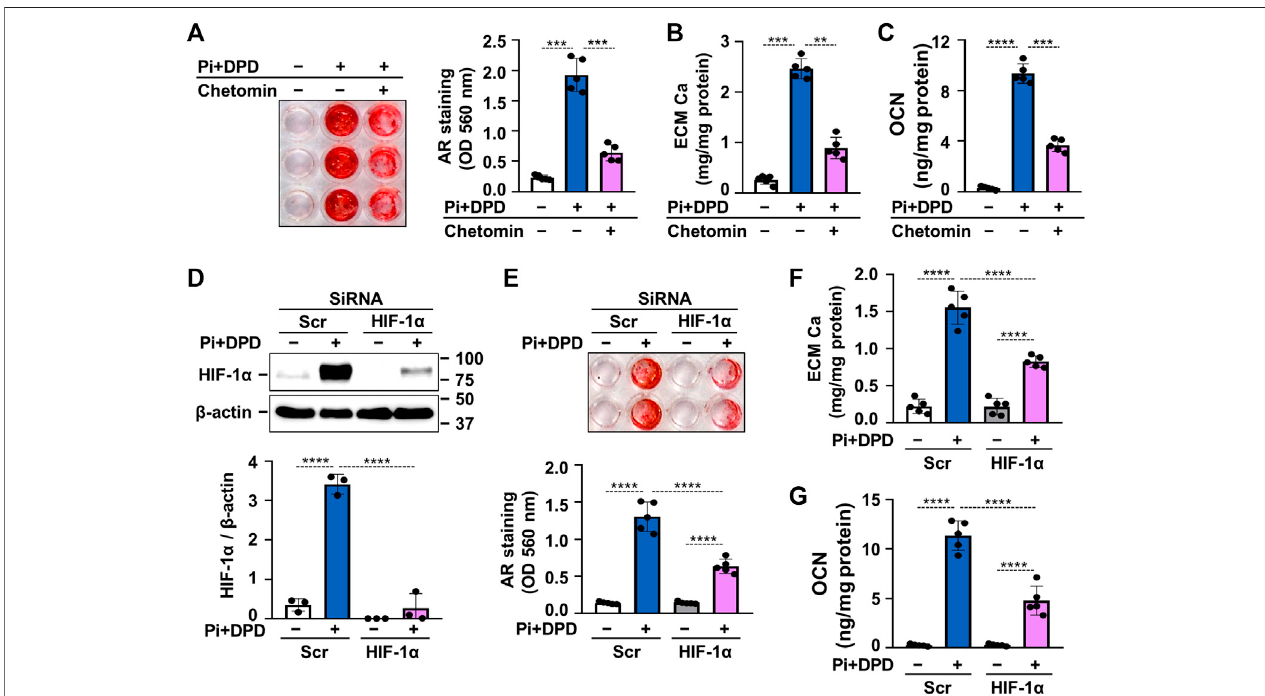
FIGURE6 | DPD increasescalci fi cation ofVSMCs through HIF-1activation. (A – C) VSMCs were exposed toPi(2 mmol/L) and DPD (10 μ mol/L) inthe presence or absence of HIF-1 inhibitor, chetomin (12.5 nmol/L). (A) Representative AR staining (day 4) and quanti fi cation. (B) Ca content of HCl-solubilized ECM (day 4). (C) OCN level in EDTA-solubilized ECM samples (day 6). (D – G) VSMCs were exposed to Pi (2 mmol/L) and DPD (10 μ mol/L) in the presence of HIF-1 α or scrambled siRNA. (D) Protein expression of HIF-1 α in whole cell lysates (24 h). Membranes were reprobed for β -actin. Representative Western blots and relative expression of HIF-1 α normalized to β -actin. (E) Representative AR staining (day 4) and quanti fi cation. (F) Ca content of HCl-solubilized ECM (day 4). (G) OCN level in EDTA-solubilized ECM samples(day6).Dataareexpressed asmean±SD, n =5except (D) ,where n =3.Ordinaryone-wayANOVAfollowedbyTukey ’ smultiplecomparisonstestswereused to calculate p values. ** p < 0.01, *** p < 0.005, **** p < 0.001.